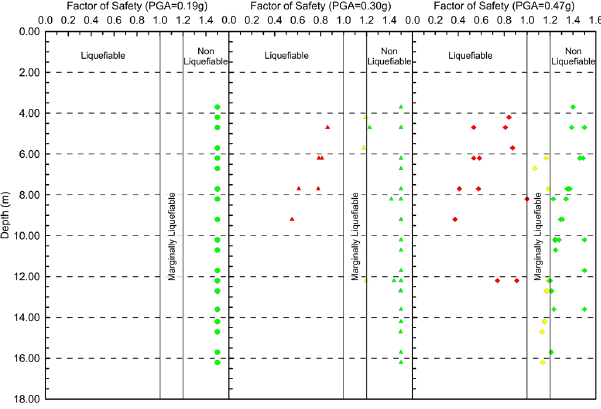
Fig. 16. Variation of safety factor versus liquefaction